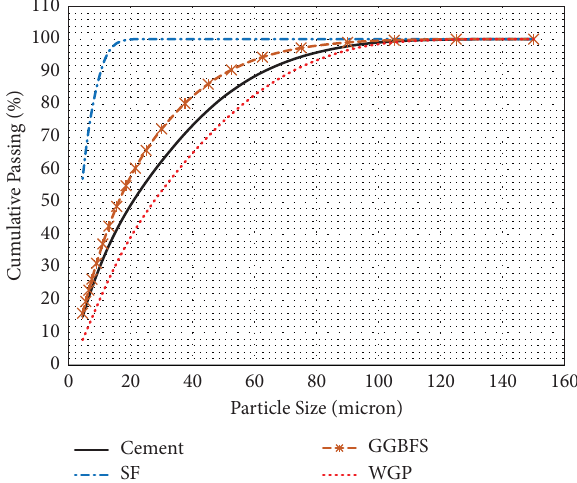
Figure 1: Te particle size distribution of cement, SF, GGBFS, and